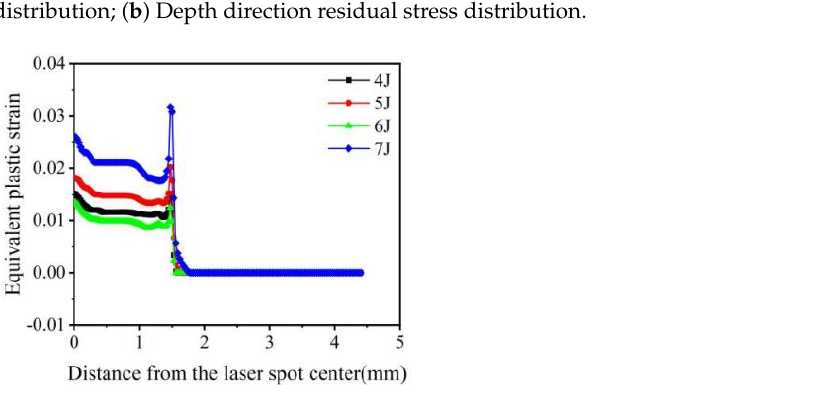
Figure 7. Equivalent plastic strain of 20CrMnTi at different laser pulse energies.